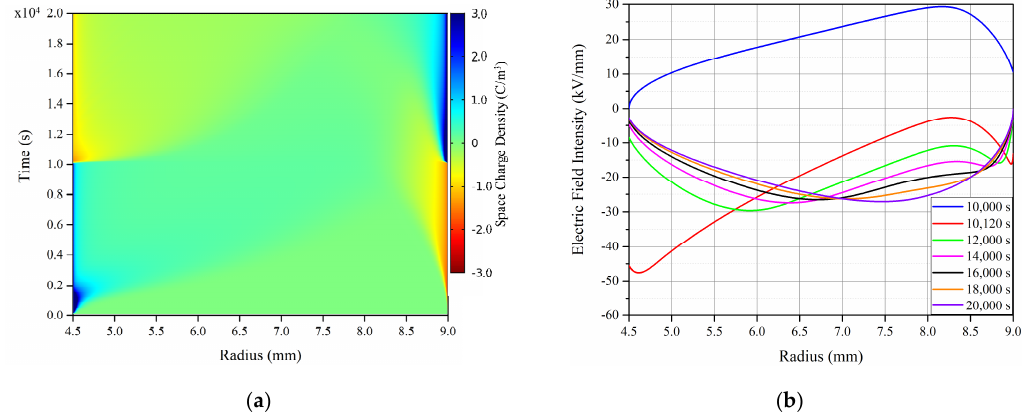
Figure 12. Simulation results after polarity reversal at 350 A: ( a ) Space charge density within LDPE (C/m 3 ); ( b ) time-varying electric field